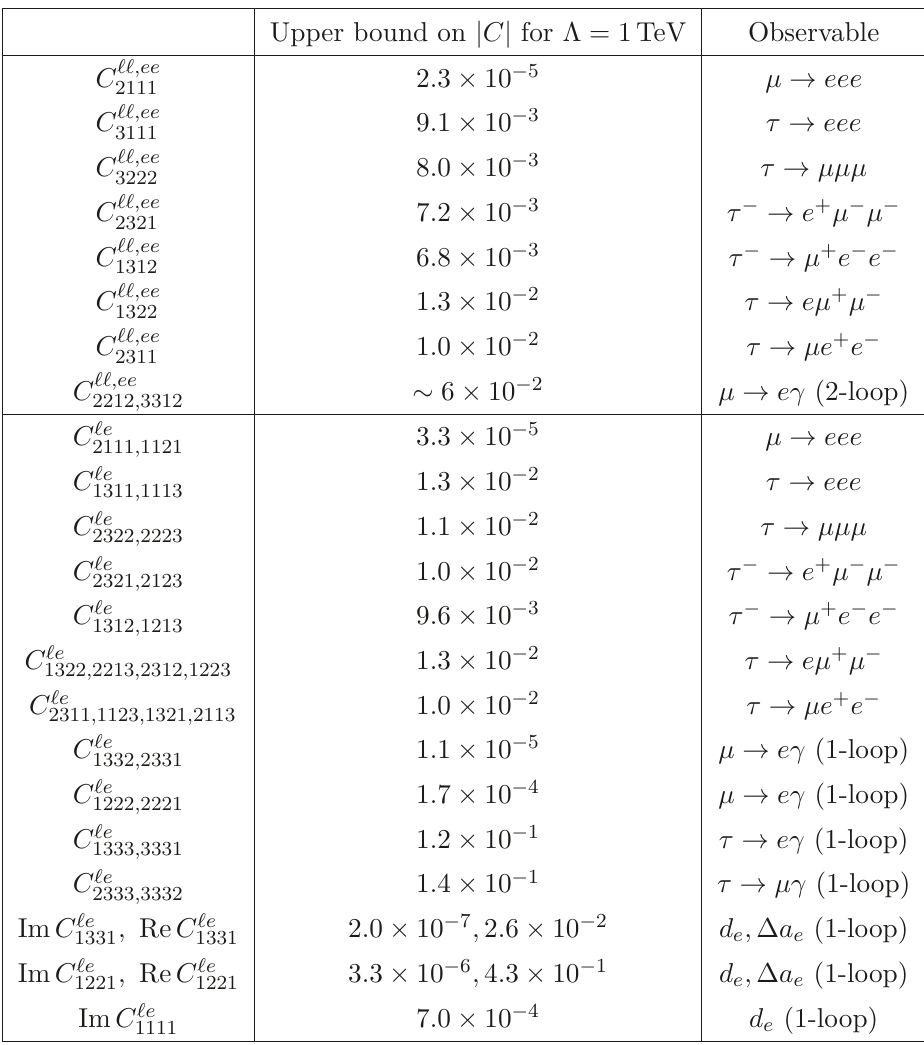
Table 5 . Most relevant constraints on the Wilson coefficients of four-lepton operators. We do not show constraints that allow Wilson coefficients of order unity or